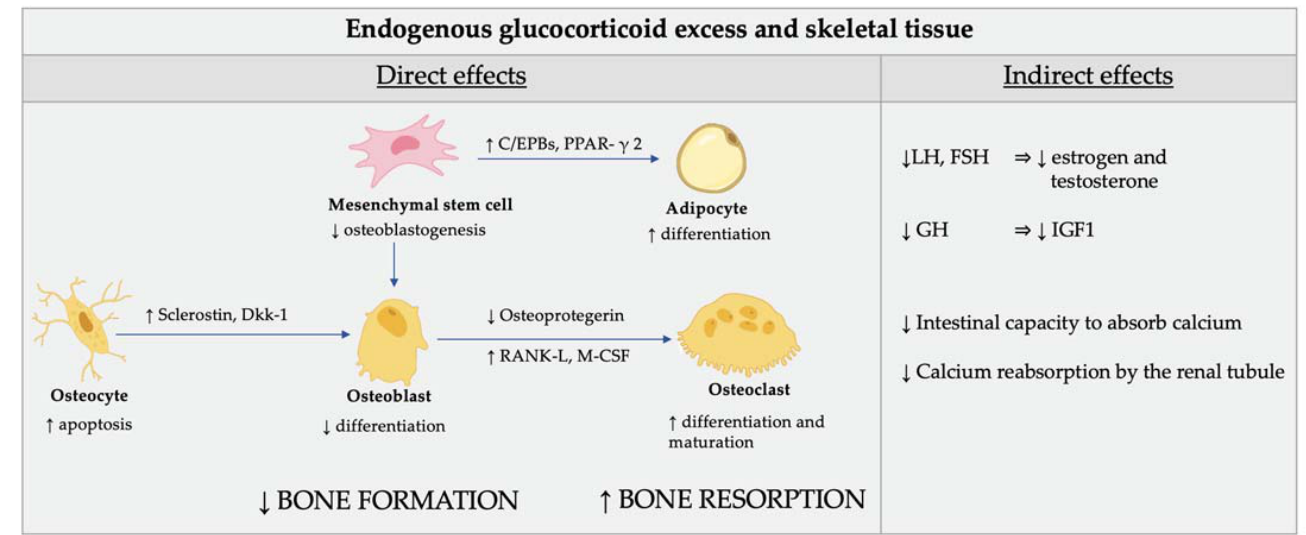
Figure 3. Direct (cellular) and indirect effect of glucocorticoid excess on skeletal tissue. Glucocorticoids (GC) reduce the osteoblastogenesis from the mesenchymal stem cells by directing their differentiation to adipocytes rather than osteoblasts. The mechanisms involved in this redirection of mesenchymal cells include induction of the nuclear factors of the CCAAT/enhancer binding protein family (C/EPBs) and of the peroxisome proliferator ‐ activated receptor γ 2 (PPAR ‐γ 2). GC also affect the function of osteocytes by modifying the elastic modulus surrounding osteocytic lacunae and induce cell apoptosis. In addition, GC induce the production of sclerostin and Dickkopf ‐ related protein 1 (Dkk ‐ 1) by osteocytes which impairs osteoblasts’ function through inhibition of Wnt signaling. The endogenous cortisol excess also induces differentiation and maturation of osteoclasts by increasing the expression of the macrophage colony ‐ stimulating factor (M ‐ CSF) and of the receptor activator of nuclear factor kappa ‐Β ligand (RANK ‐ L) and decreasing the expression of its soluble decoy receptor, osteoprotegerin, in stromal and osteoblastic cells. As a result, the normal maintenance of the bone is impaired and the bone biomechanical properties are compromised. The indirect effects of GC on bone are mediated by their inhibition of the gonadotropins release, which, in turn, affects estrogen and testosterone production. Finally, GC plays a role in the inhibition of the production of growth hormone and insulin ‐ like growth factor, which are important stimulators of osteoblasts. Calcium homeostasis is also adversely affected by GC. The intestinal capacity to absorb calcium is lowered and calcium reabsorption by the renal tubule is inhibited by GC.